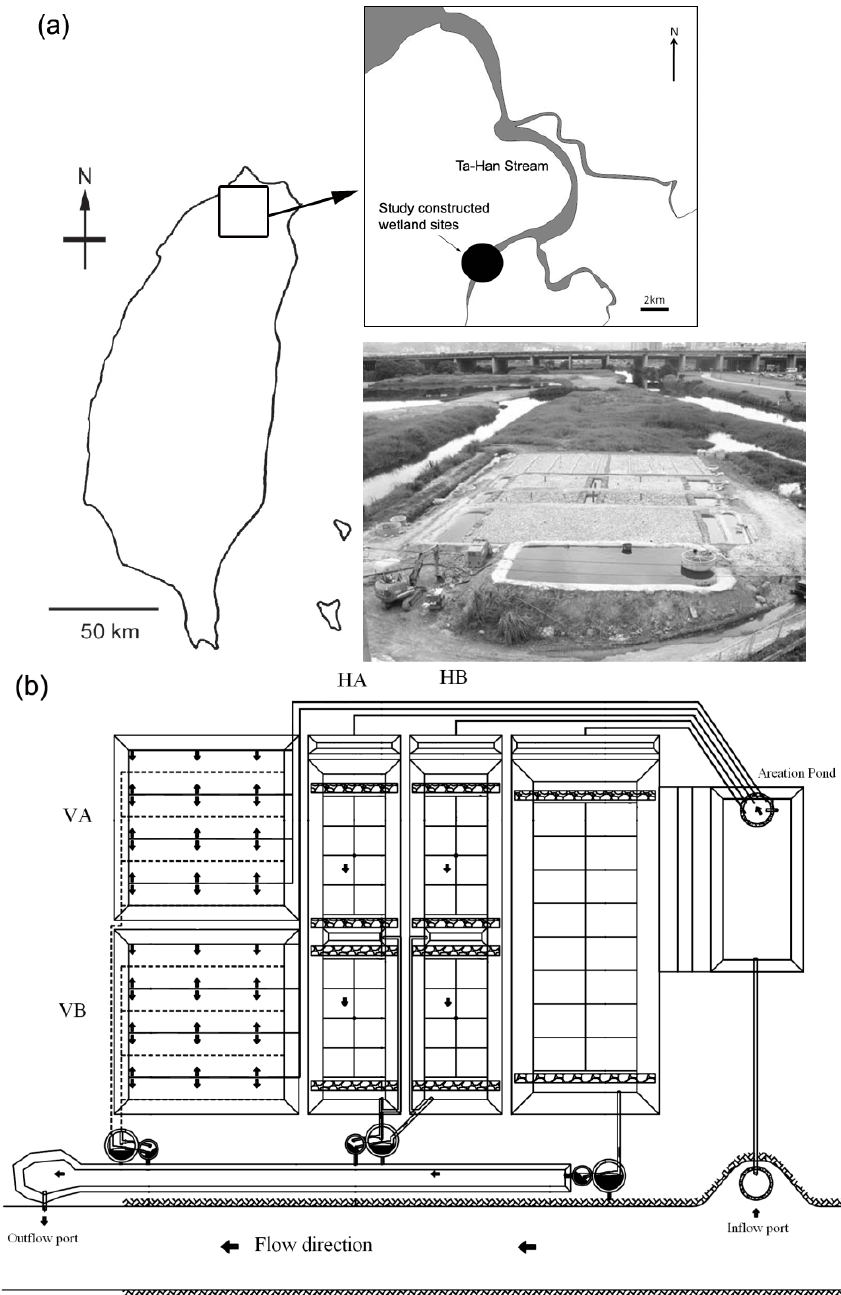
Figure 1. ( a ) Configuration; and ( b ) arrangement plan of the constructed wetlands (CWs) [16]. VA, VB, HA and HB were built with bagged oyster shells, scattered oyster shells, scattered oyster shells and gravels as adsorption media